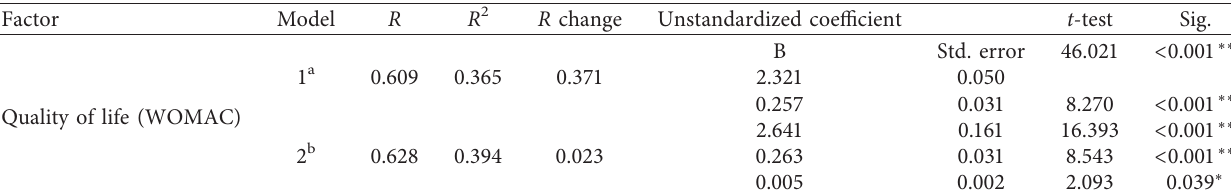
Table 6: Results of linear regression analysis (stepwise regression) for quality-of-life predictors ( N �